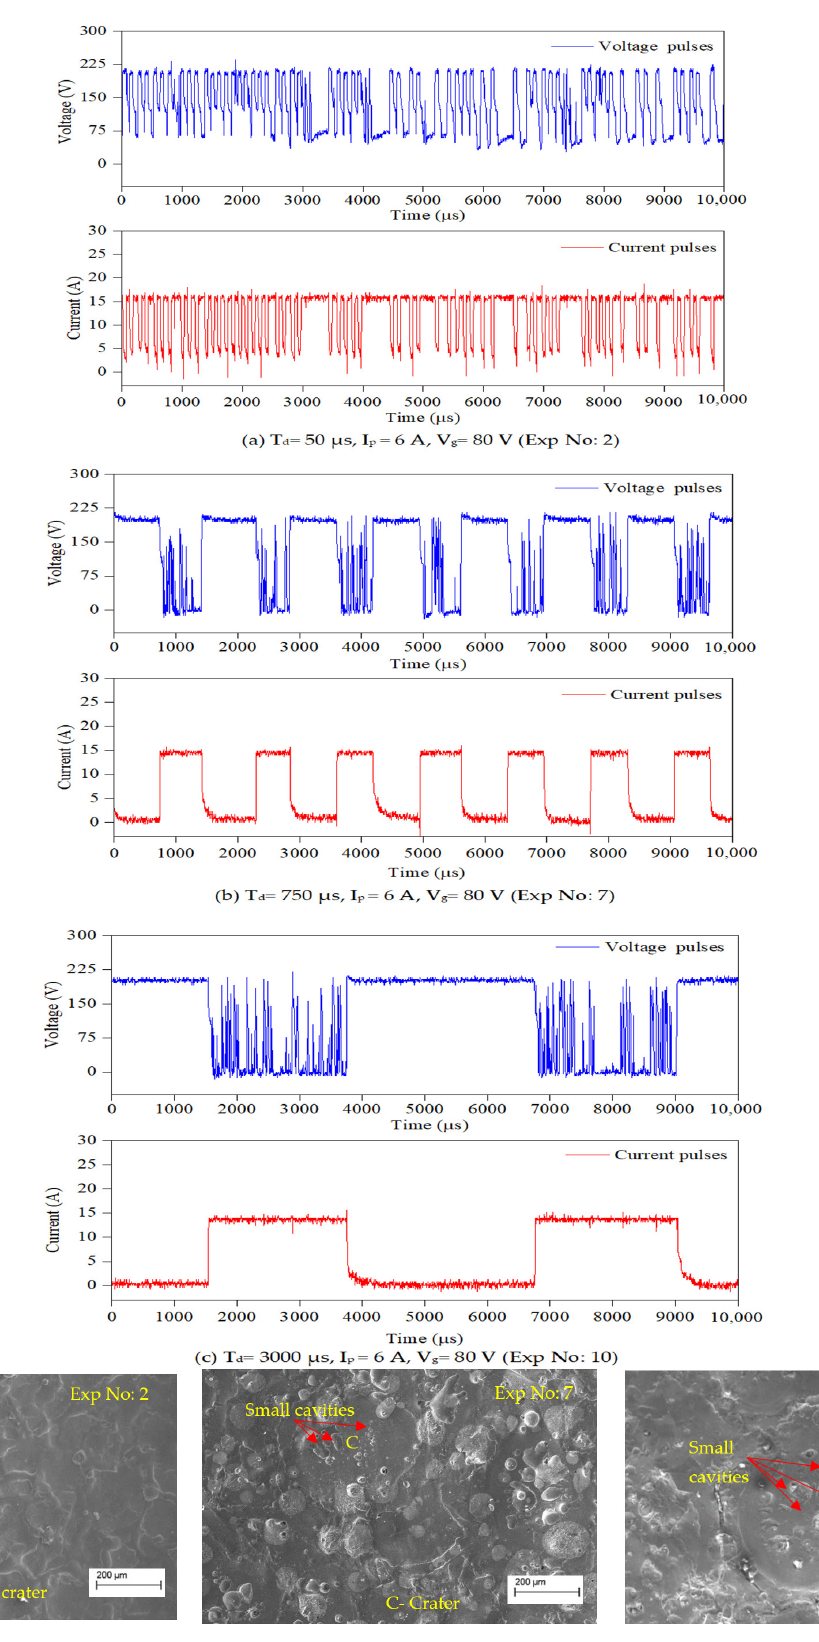
Figure 10. Typical pulse trains data and SEM micrographs for Φ40 μm at various discharge durations (C-crater, PD-partial discharge).